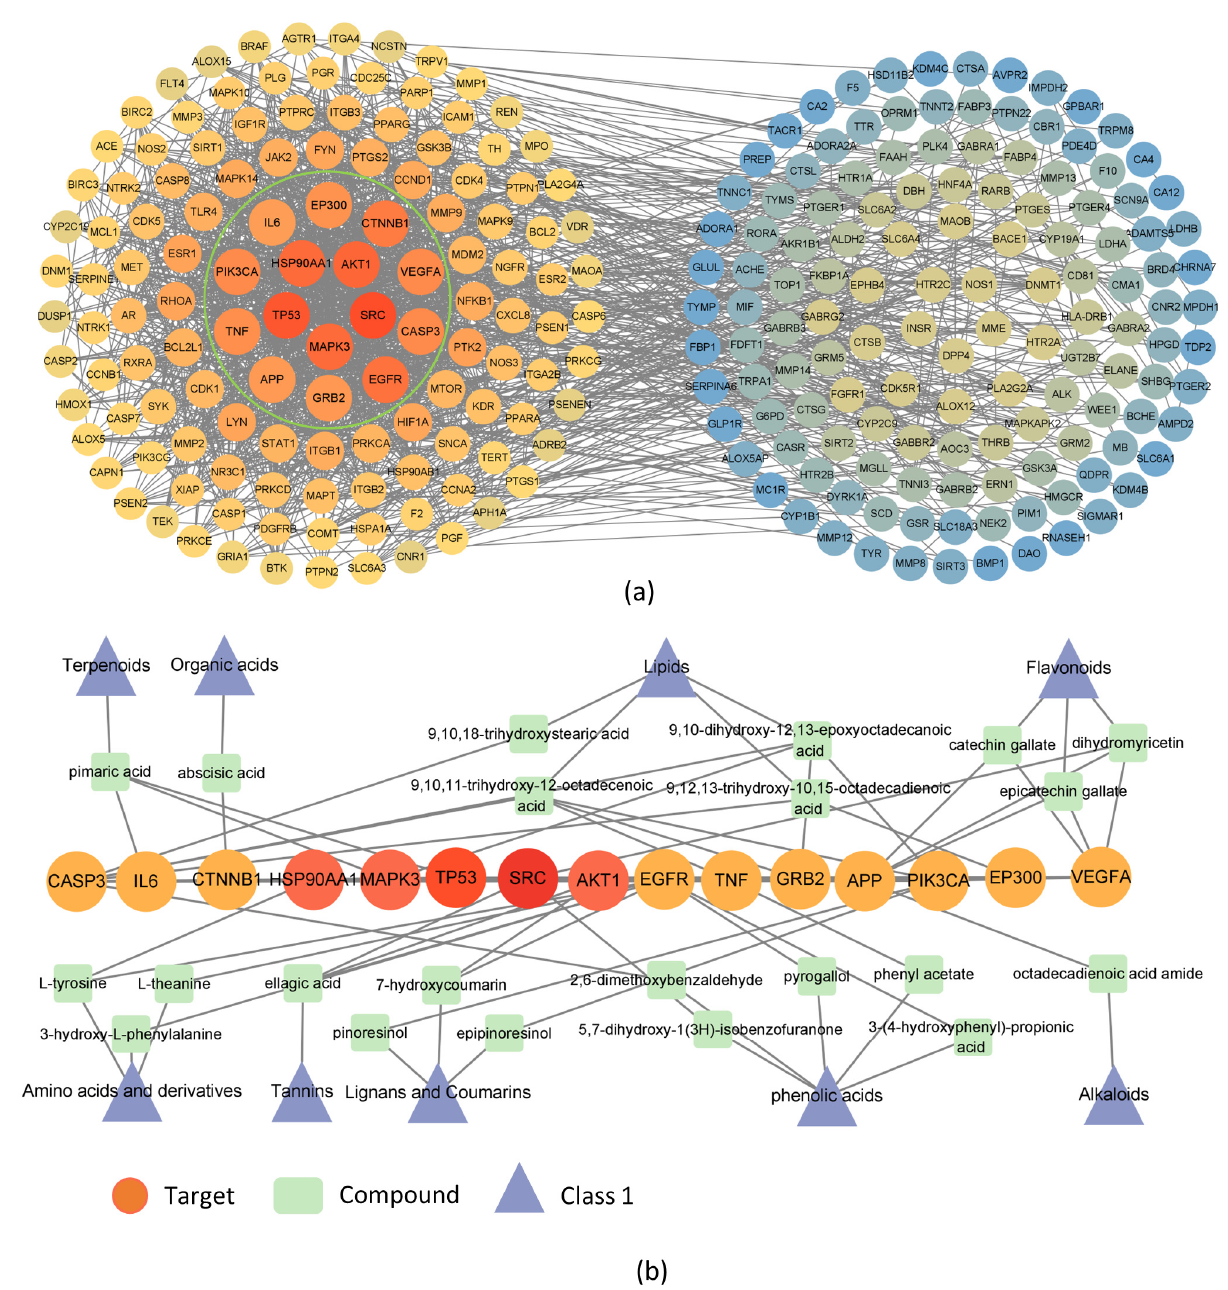
Figure 7. Network pharmacological analysis of active components of ALPT water extract and degenerative changes in the body. ( a ) PPI network analysis of the crossing genes. The genes in the PPI map on the left were the nodes whose degree value is greater than the median value, and those on the right were the nodes whose degree value is less than the median value; The more yellow the color, the greater the degree value. ( b ) The association analysis of the active substances and the most significant 15 target genes in the PPI network diagram.